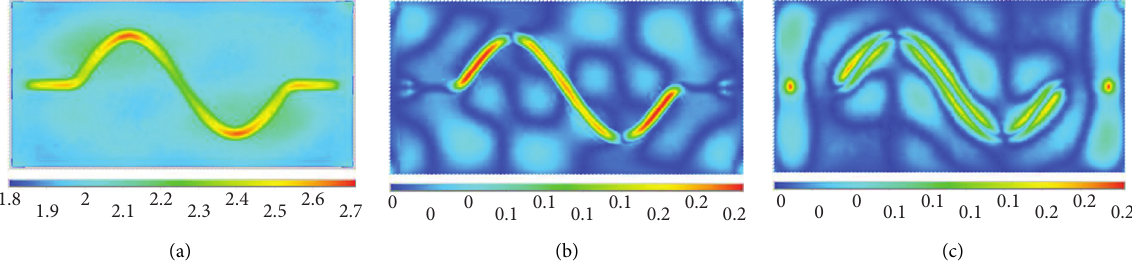
� 500m/s, and NR � 2). Top view displacement cloud view (a) u s